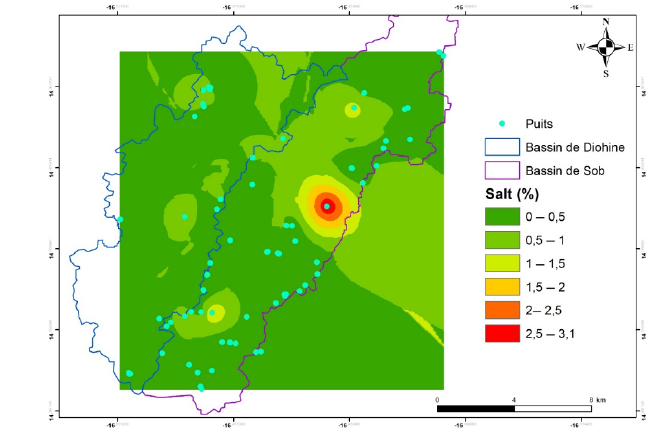
Figure 6. Distribution of static levels (NS) of wells in the Sob and Diohine watersheds.